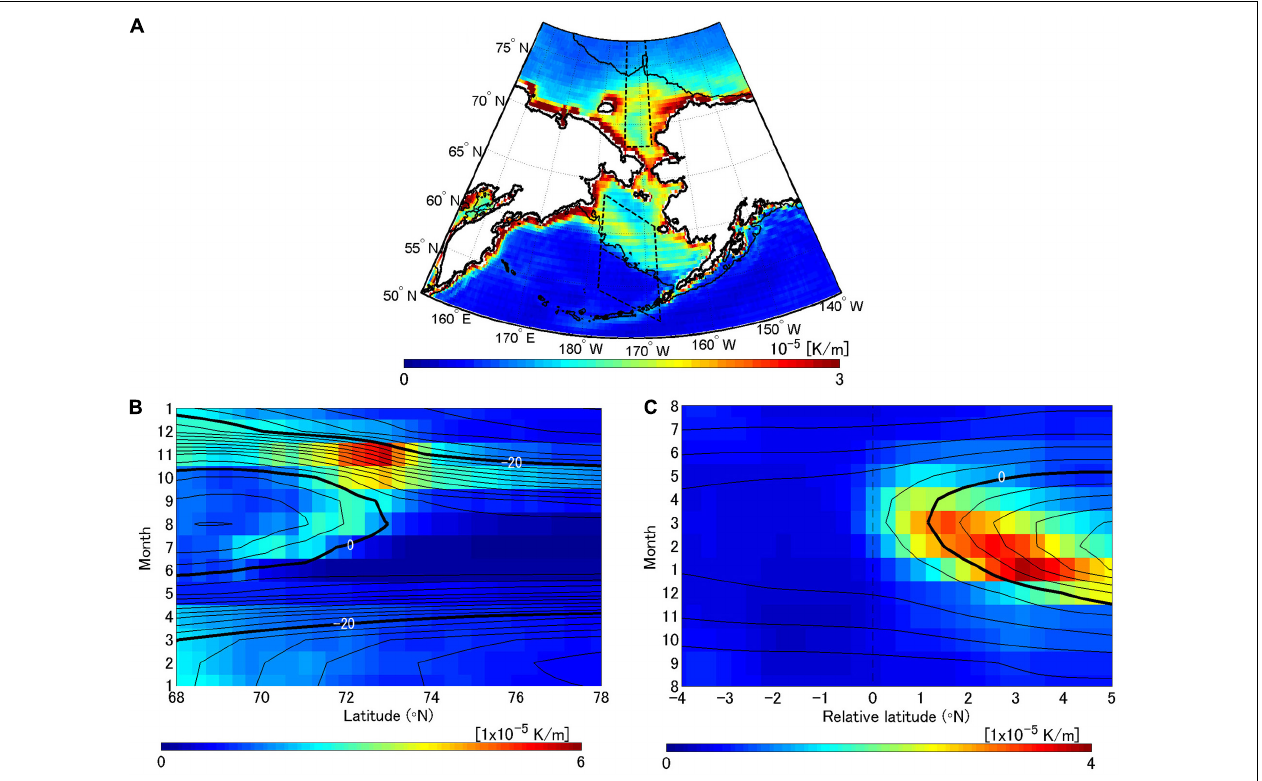
FIGURE 1 | (A) Annual-mean climatology of the Euclidean norm of horizontal gradient of ST, and latitude-time sections of monthly climatological data of the ST horizontal gradient in (B) the Chukchi Sea and (C) the Bering Sea. Black solid lines in (A) are depth contours of 200 m. The areas enclosed with black dashed lines in (A) are the domains for (B,C) . The middle dashed line near the 200-m-contour in the Bering Sea is the coordinate origin of latitude for (C) . Contours in (B,C) show ST, and the intervals indicated by thin and bold contours in (B,C) are 2 and 20 ◦ C, respectively.